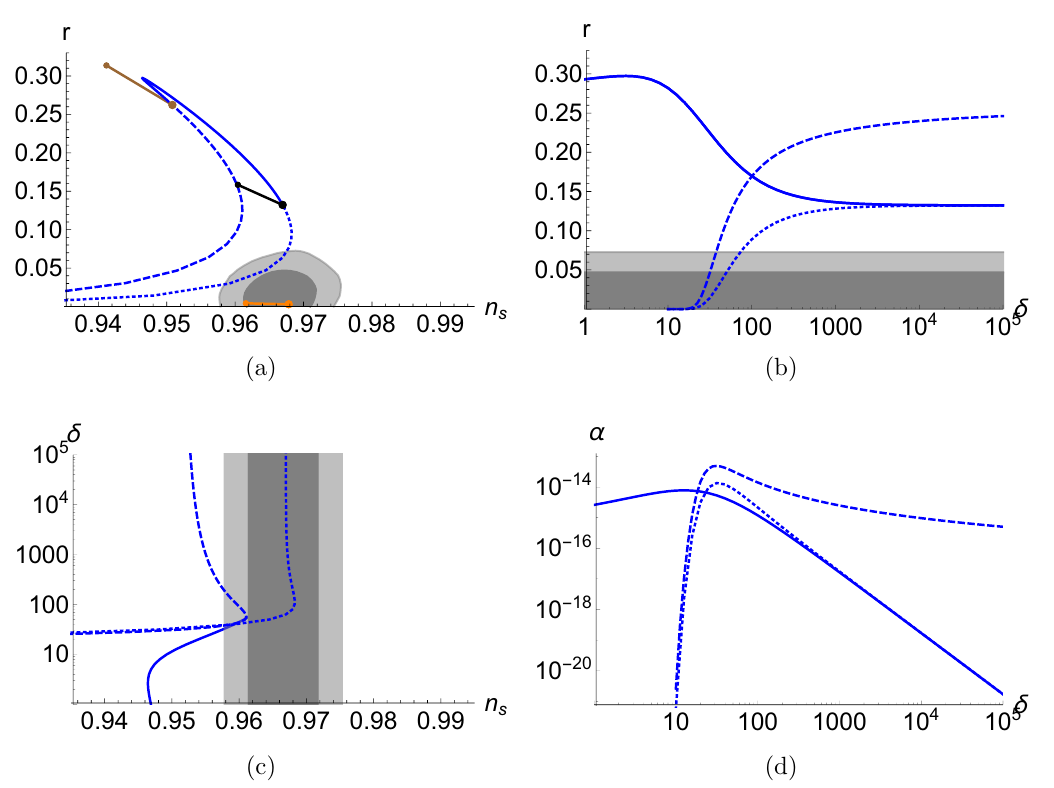
Figure 4. r vs. n s (a), r vs. δ (b), δ vs. n s (c), and α vs. δ (d) with N e = 60 e -folds for the CW potential (2.10). Blue dashed line represents inflation in region 1), blue dotted line in region 2) and blue continuous in region 3). For reference we plot the lines for quartic (brown), quadratic (black) and R 2 (orange) inflation for N e ∈ [50 , 60] . The gray areas represent the 1,2 σ allowed regions from Planck 2018 data [6].